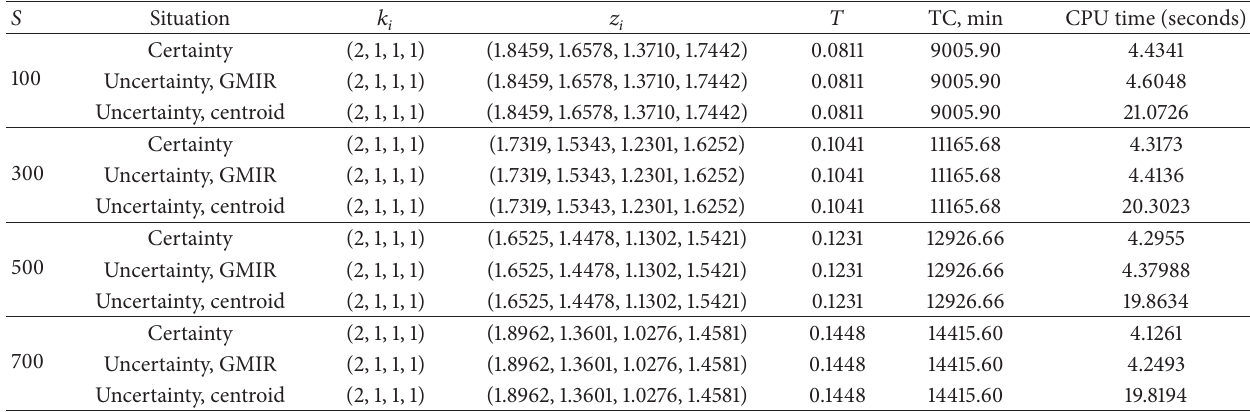
Table 8: Results comparison under different situations (scenarios 2).